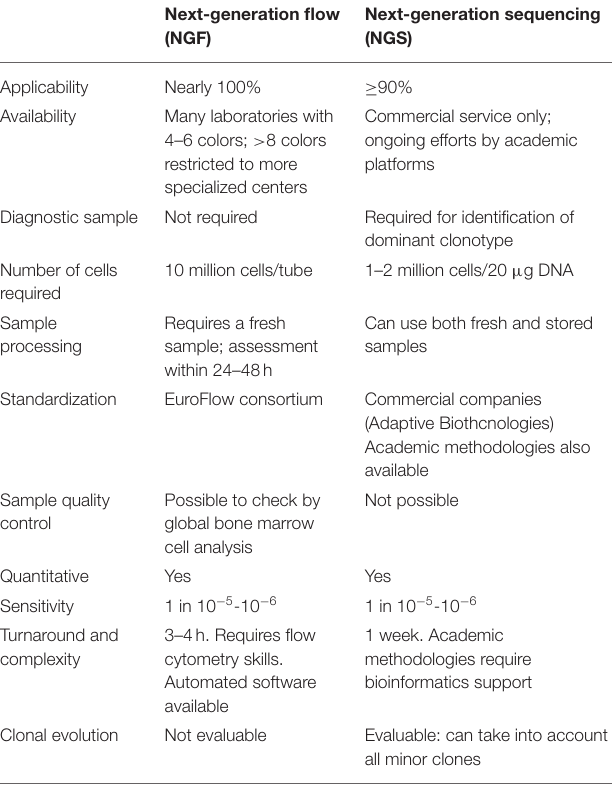
TABLE 1 | Bone marrow techniques for MRD in myeloma: pros and